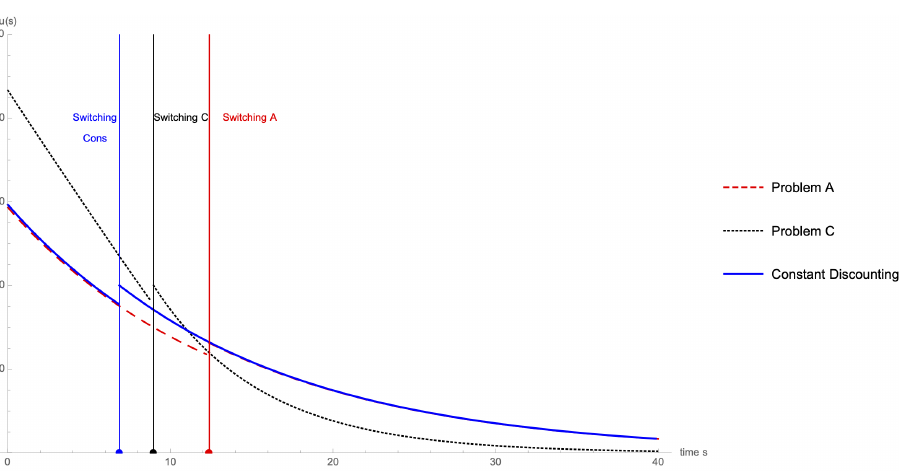
Figure 1. Evolution of the resource stock.